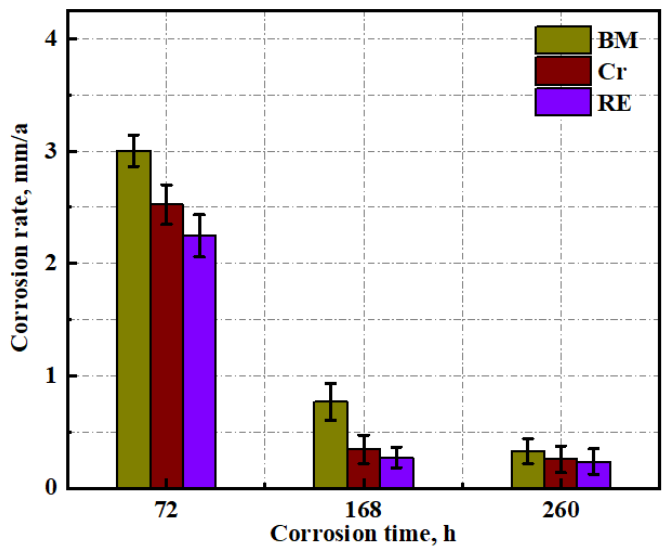
Figure 11. Corrosion rate of the three steel rebars after dry/wet cyclic tests. For discussing the functions of Cr and RE on the rust layer’s protectiveness, the cross-sectional morphologies and element distribution mappings were characterized and presented in Figure 12. As the rust layer after 3 days was heterogeneous and thin, the rust layers after 7 and 15 days were chosen and further analyzed. For the rust layer after 7 days, the rust layers of the Cr and the RE rebars formed a layered structure containing the outer rust layer and the inner rust layer. In contrast, the rust layer of BM still did not form a dense inner rust layer. Thus, in the elemental analysis, it can be found that the rust layer of BM was entered and enriched with a large amount of Ca from the environment, whereas in the rust layers of Cr and RE, Ca was mainly concentrated in the outer rust layer and was present a low content. A large amount of Cl could be found in the rust layer of BM and an enriched zone of Cl was present at the interface between the rust layer and the substrate. No enriched zone was found in the rust layer of Cr, and the Cr enrichment zone was observed in the inner rust layer, but significant amounts of Cl were still present. observed, while La and Ce were diffusely distributed throughout the rust layer. Cl was enriched in the outer rust layer, which indicates that the rust layer had good protective properties